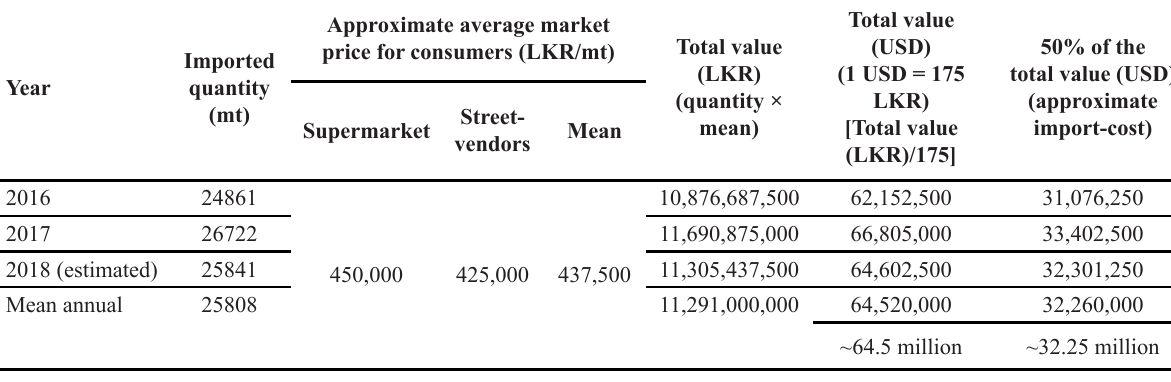
Table 4: The estimated cost for importing apple to Sri